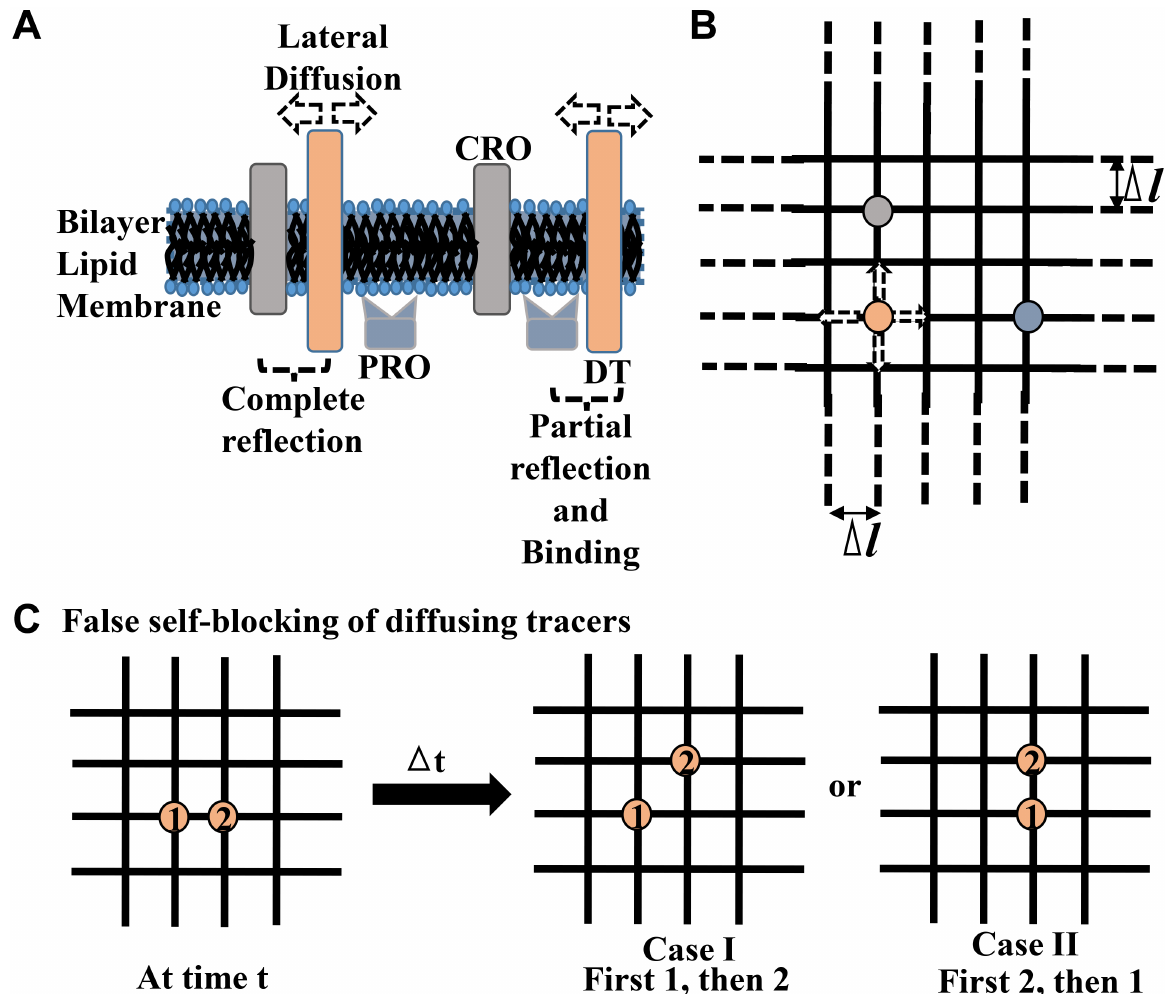
Fig 1. The simplified molecular composition of PSD and lattice model of AMPA receptor diffusion. (A) An schematic demonstration of the CROs and PROs under the broad classification adopted here for the various crowding elements present at the PSD of a typical excitatory synapse on a dendritic spine. CROs are generally the transmembrane proteins which interact with a diffusing receptor only to elastically repel it away on collision. PROs are typically the submembranous scaffold proteins which offer partial reflection as well as binding to diffusing receptors. The AMPAR lateral diffusion is modeled here using a transmembranous diffusing tracer (DT). (B) A part of the entire lattice illustrating a discrete space for the tracer diffusion. DT, CRO and PRO are localized on the lattice as point elements, with different respective area fractions. A tracer can diffuse randomly to either of the four directions. Δ l is the size of the lattice edges between any two lattice points. The entire lattice is an abstraction meant to be used here for representing receptor diffusion over either the entire PSD or a region within the PSD. (C) An illustration of the false self-blocking of two DTs, labelled 1 and 2, lying at the neighbouring lattice sites. The different computational sequences of performing the hopping of these DTs may lead to different new configurations of the tracers localizations on the lattice. One of these configurations is false, viz. Case I, with respect to the ideal concept of simultaneous diffusion of the tracers over a time-step of simulation. Its description is provided in the text.